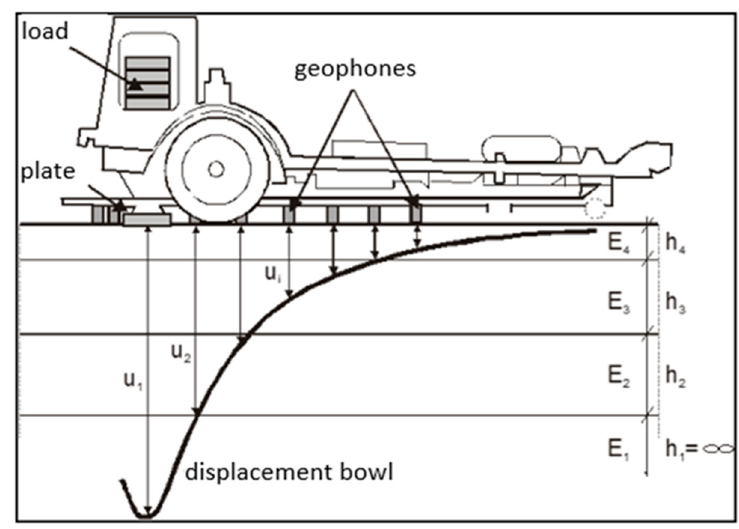
Figure 11. Measurement diagram done with an FWD deflectometer.